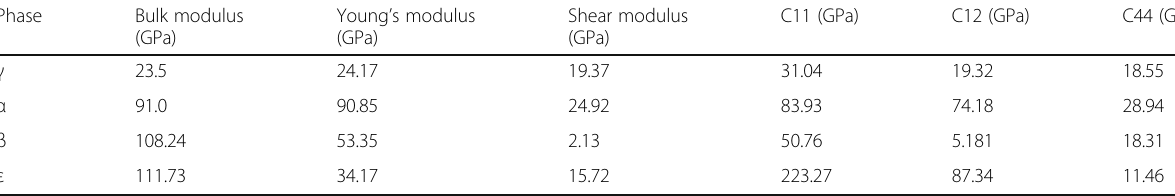
Table 2 Elastic constants and mechanical properties of cerium phases